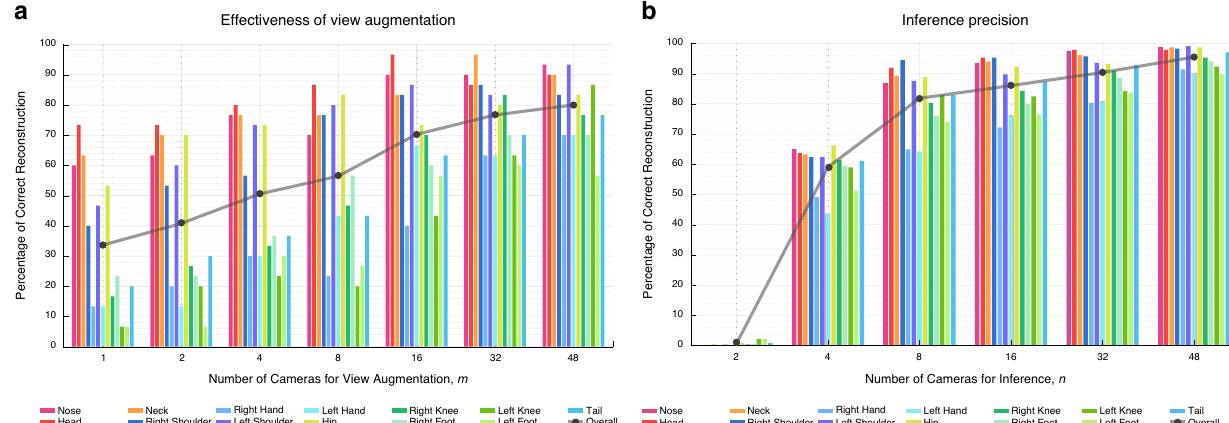
Fig. 4 Augmentation and inference performance. a View augmentation improves the accuracy of reconstruction. A subset of cameras are used for view augmentation and the relative accuracy is measured by comparing to the full model that is trained by 62 camera augmentation ( m = 62). While the landmarks that are relatively rigid shape such as nose, head, neck, and hip can produce accurate reconstruction with small augmentation, the limb landmarks such as hands, knees, and feet require greater augmentation. The overall accuracy is improved from 34% ( m = 1) to 76% ( m = 48), which justi fi es the multiview augmentation. b Once the detection model is trained with the full view augmentation ( m = 62), a subset of cameras can be used to achieve comparable performance. The relative accuracy is measured by comparing to n = 62. For instance, eight cameras can achieve 80% overall performance. However, the limbs with high degrees of freedom such as hands, knees, and feet require more cameras to reach comparable levels.